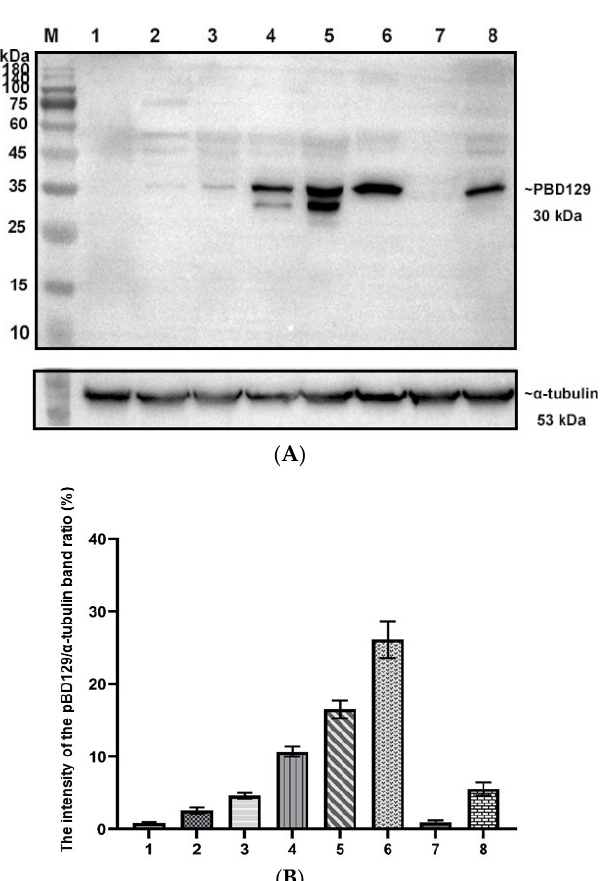
Figure 4. Expression and distribution of pBD129 in the porcine reproductive system. ( A ) Western blot analysis of pBD129 protein in reproductive organs of adult boars. M: 180 kDa protein marker; Lane 1: Testicles; Lane 2: Caput epididymis; Lane 3. Corpora epididymis; Lane 4: Caudal epididymis; Lane 5: Vas deferens; Lane 6: Seminal vesicle gland; Lane 7: Bulbous urethral gland; Lane 8: Prostate. ( B ) The intensity of the pBD129 protein band of Western blot analysis was compared by ImageJ software. α -tubulin as internal control and normalization. Data are presented as the mean ± SEM, n = 3.